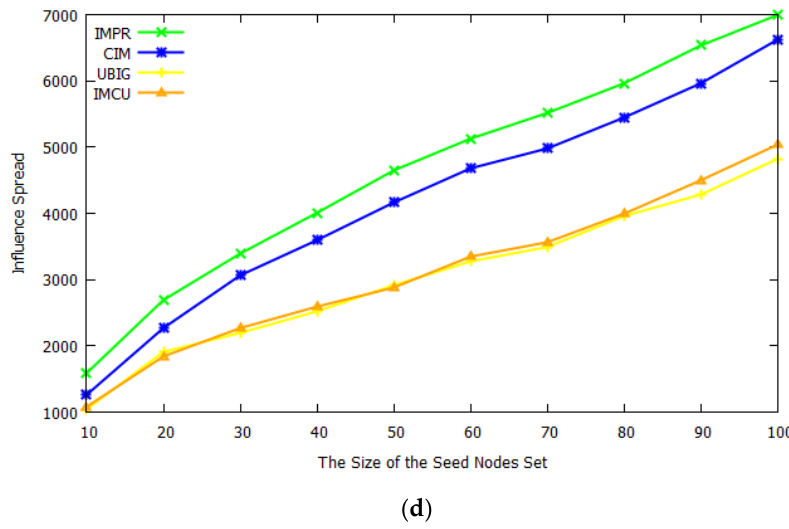
Figure 5. Influence spread of seed nodes selected by IMPR and three other algorithms on different datasets. ( a ) Comparison of IMPR and three other algorithms on the CollegeMsg dataset. ( b ) Comparison of IMPR and three other algorithms on the Mathoverflow dataset. ( c ) Comparison of IMPR and three other algorithms on the Superuser dataset. ( d ) Comparison of IMPR and three other algorithms on the Stackoverflow dataset.